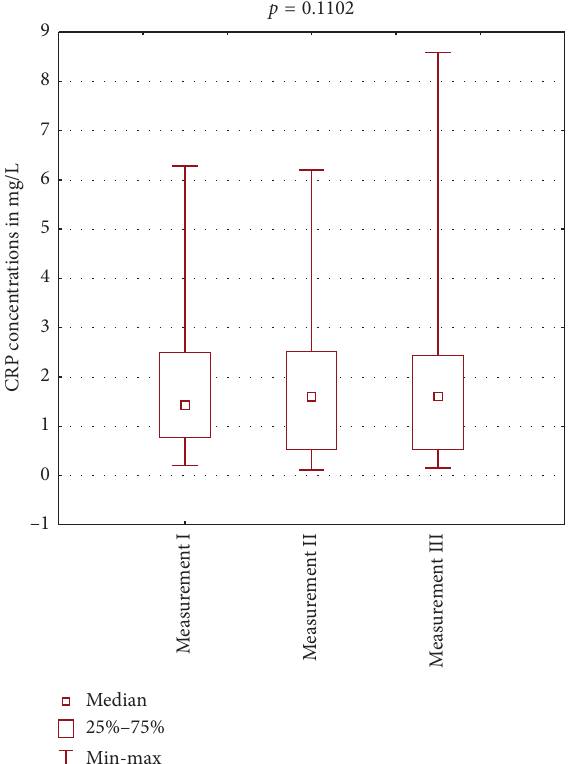
Figure 1: In-group comparisons of the results of measurements I, II, and III—the study group.